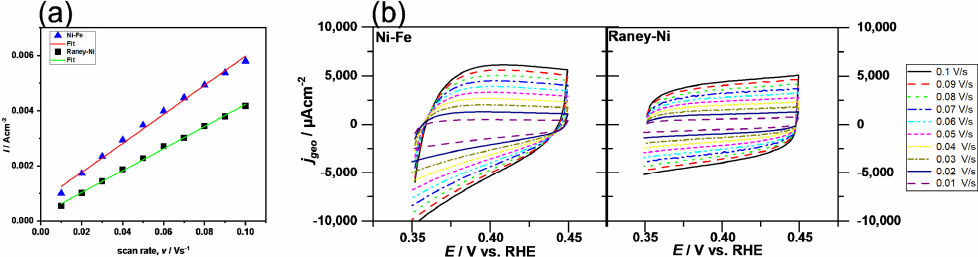
Figure 7. Galvanostatic curves for (a) plot of the average current density at 0.4 V (vs RHE) vs the scan rate (extracted from ( b )) and (b) CVs for Ni-Fe and Raney Ni electrodes at different scan rates.